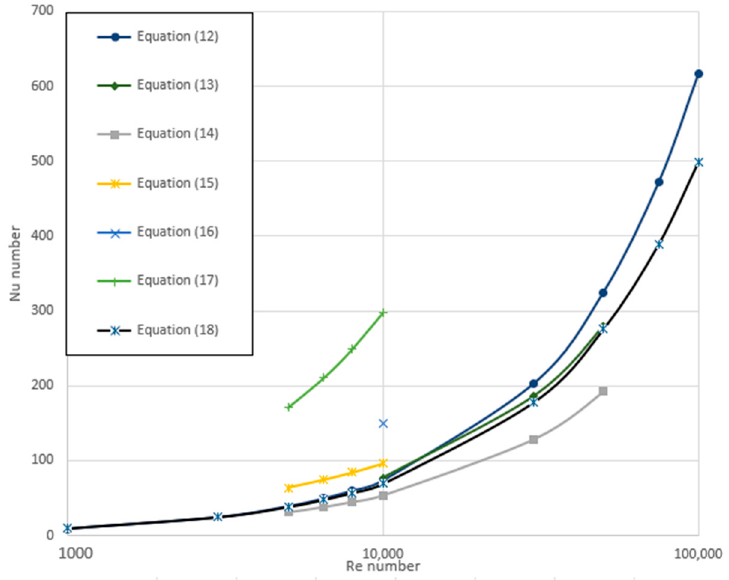
Figure 2. Nu-Re relationships for water-Al 2 O 3 nanofluids.